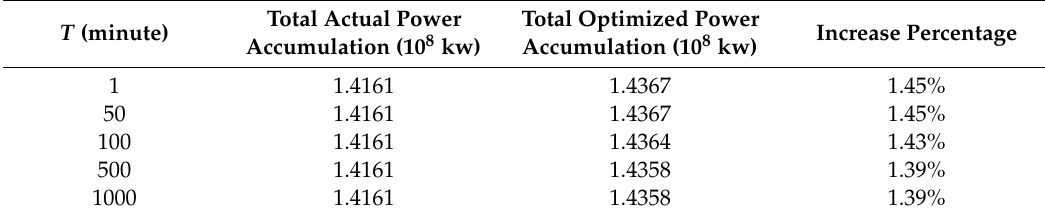
Table 7. Power optimization results on #6 under di ff erent period.